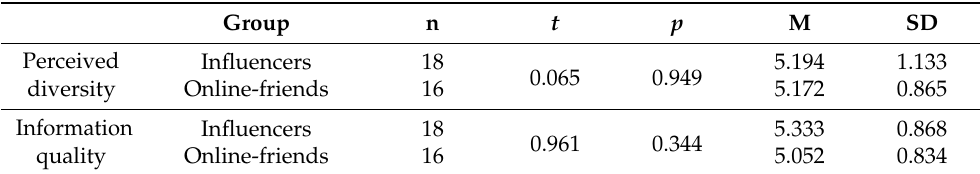
Table 5. Results of the independent sample t-tests for H3a and H3b.